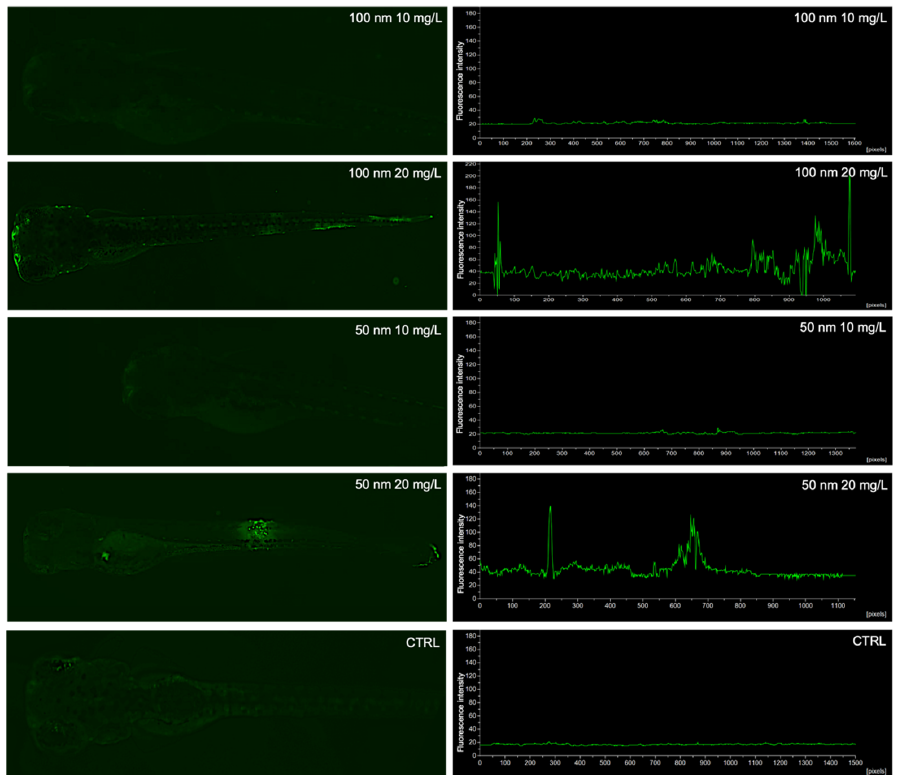
Figure 7. Localization of oxidative stress on D. rerio larvae exposed to nPS-NH 2 and in the control group. Fluorescence peaks indicate the presence of ROS.